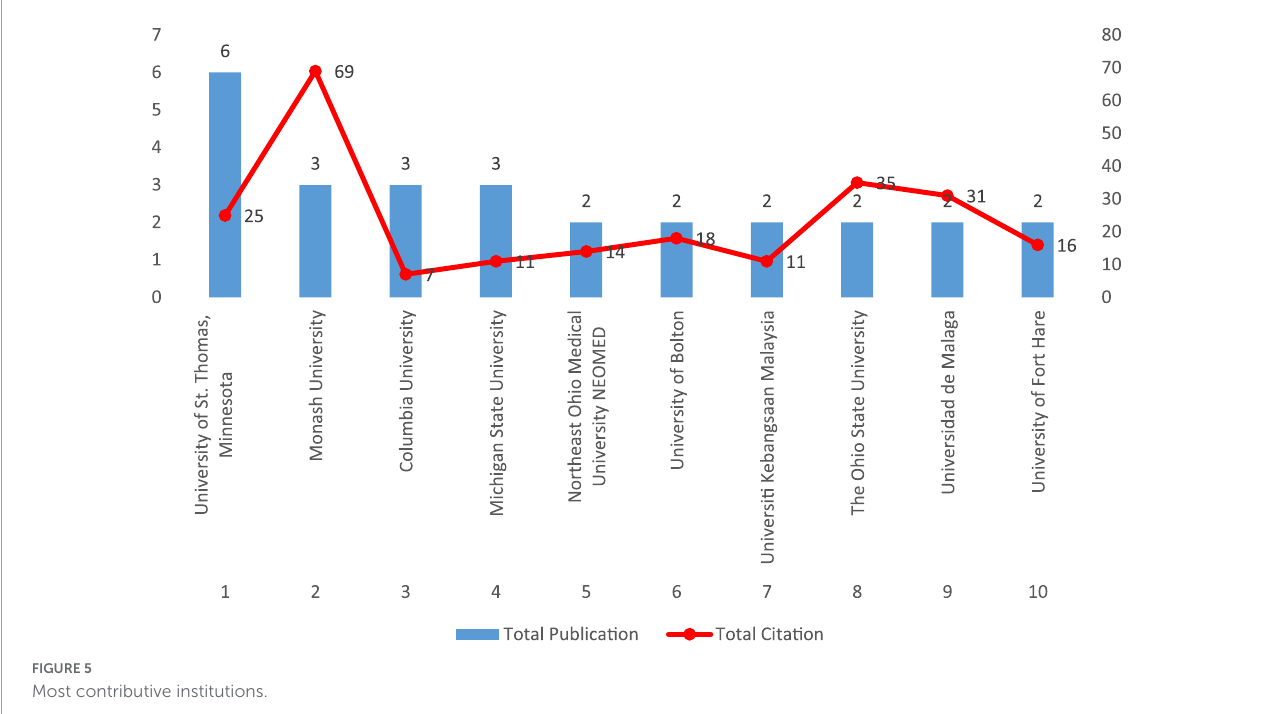
FIGURE5 Most contributive institutions.